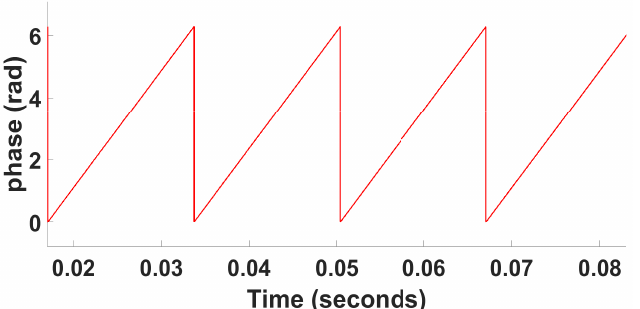
Figure 15. Grid position during voltage sag under the presence of 5th, 7th, 11th, 13th, 17th, and 19th harmonics components.